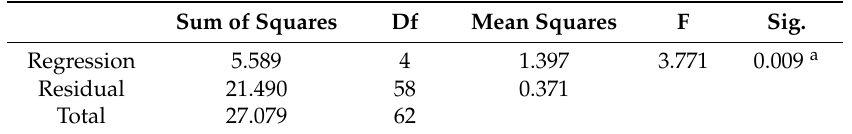
Table 8. The regression analysis of the factors on the overall value evaluation by students. Sum of Squares Df Mean Squares F Sig. Regression 5.589 4 1.397 3.771 0.009 a